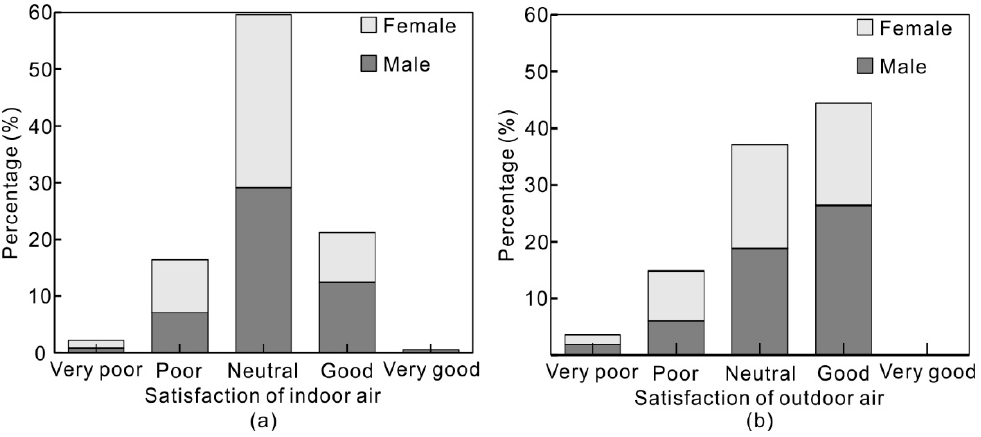
Figure 2. ( a ) Indoor perceived air quality; ( b ) Outdoor perceived air quality.